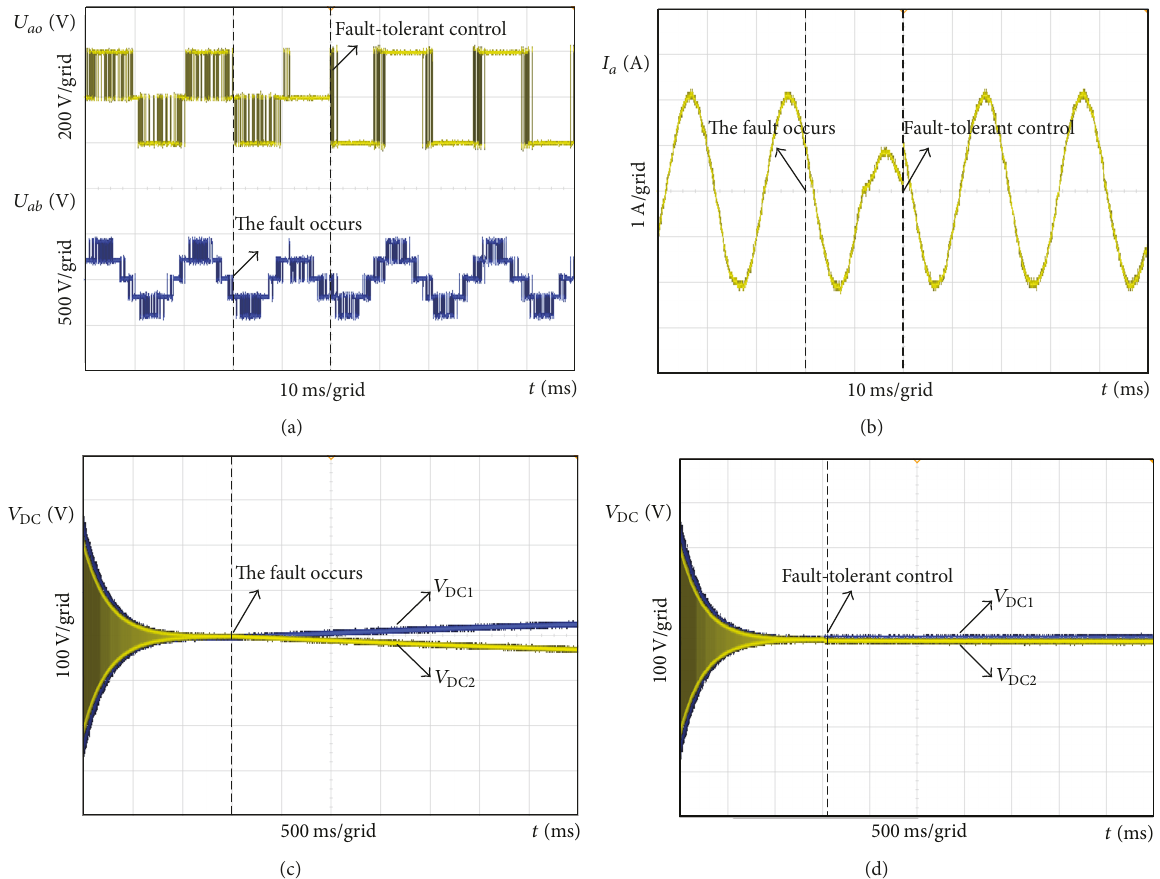
Figure 10: Experimental waveforms. (a) 𝑈 𝑎𝑜 and 𝑈 𝑎𝑏 . (b) 𝐼 𝑎 . (c) Capacitor neutral-point voltages before fault-tolerant control. (d) Capacitor neutral-point voltages after fault-tolerant